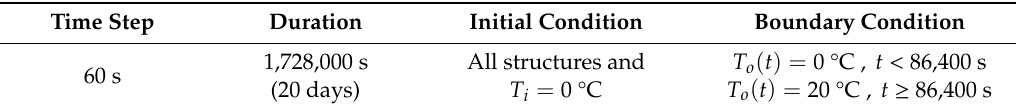
Table 3. Simulation